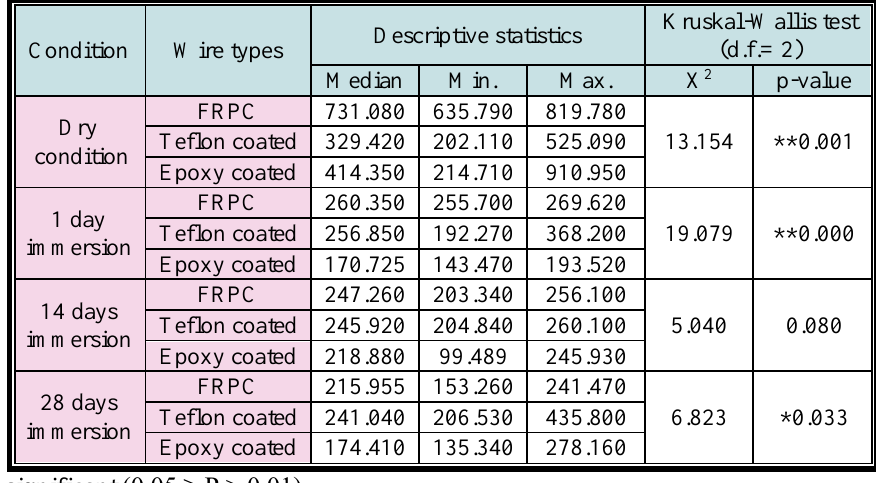
Table 3: Medianvalues of the maximum roughness height (R y )in nm of different esthetic archwire type.